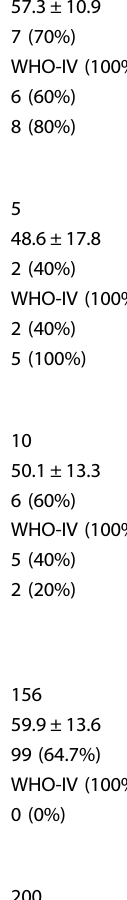
Table 1. Tabular summary of the demographic and clinical characteristics of patients with GBM and control